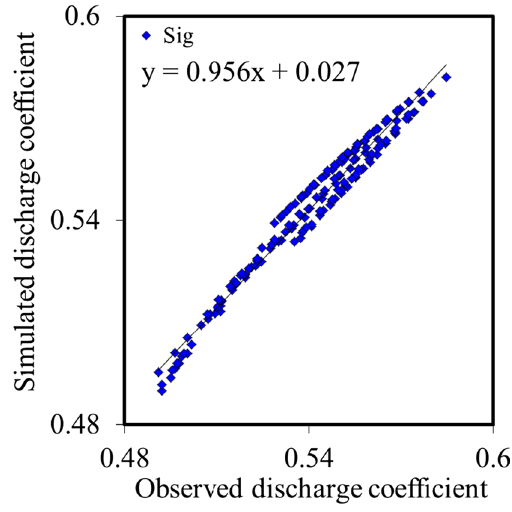
Fig. 8 Scatter plot of activation function